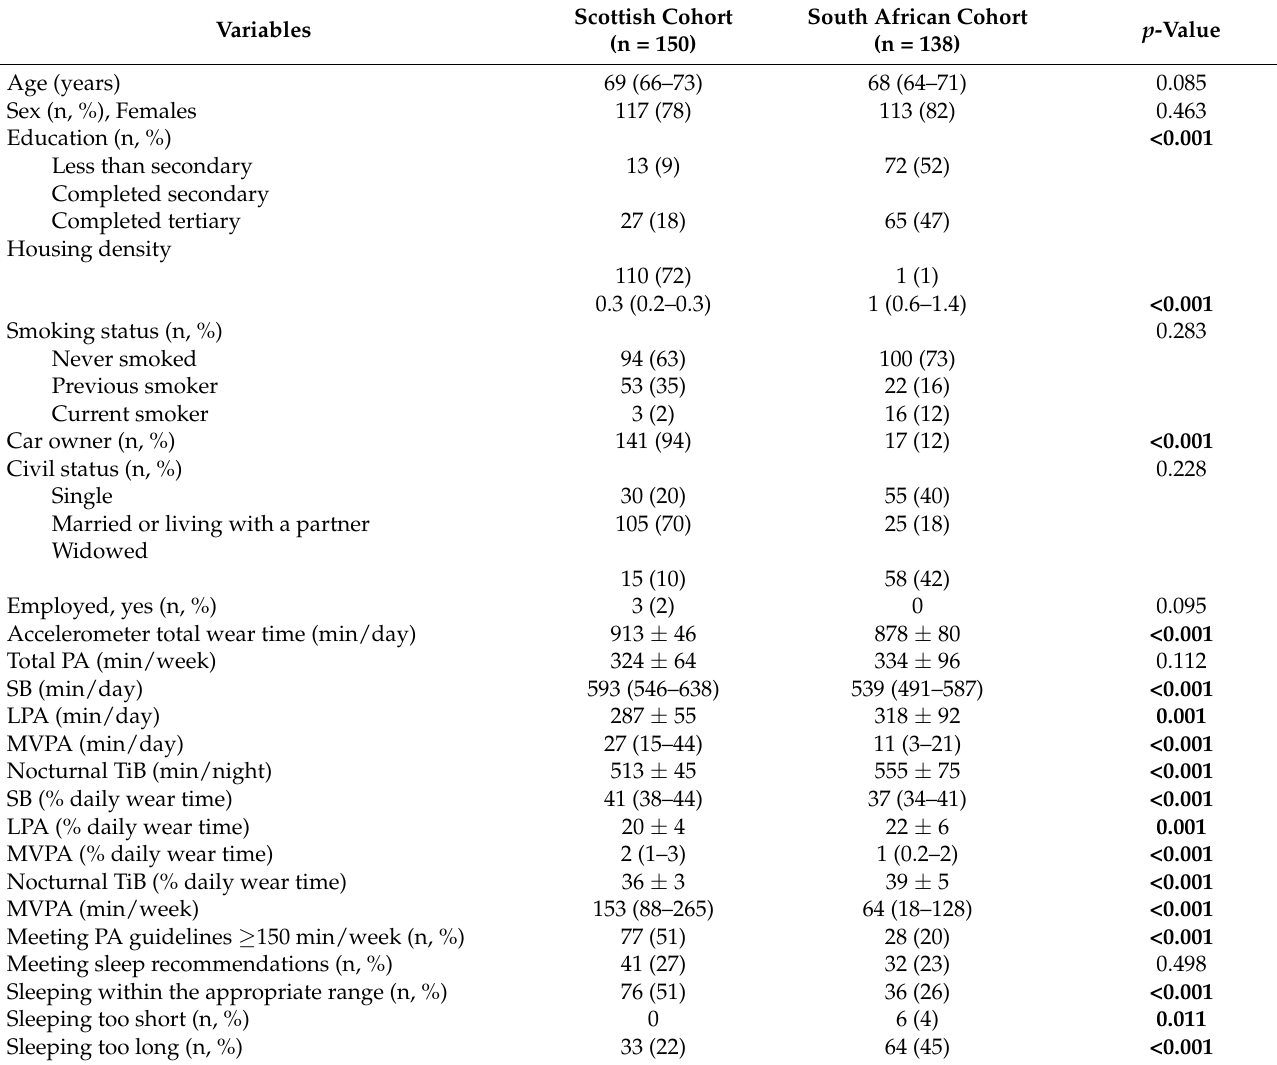
Table 1. For compositional data analysis, compositional means of movement behaviors were considered (Table S1). χ 2 (chi-squared) or Fisher’s exact test (where appropriate) was conducted to determine differences in sleep sub-components of the PSQI (Table S2). Table 1. Descriptive characteristics of Scottish and South African